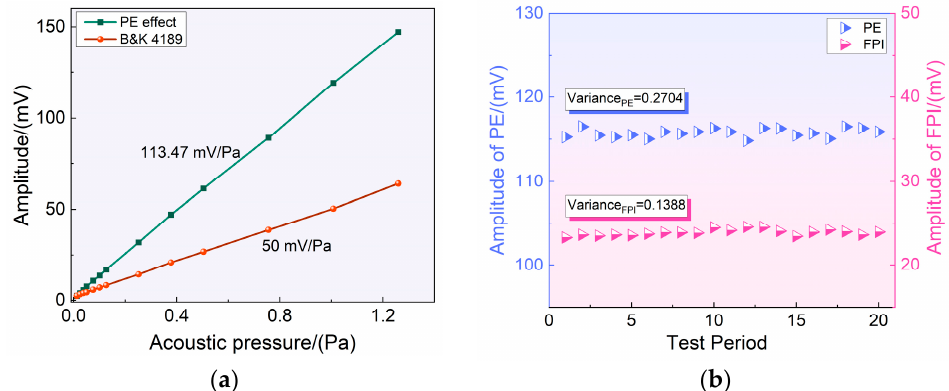
Figure 4. ( a ) Relationship between the piezoelectric effect signal and sound pressure level at the formant; ( b ) stability test of the resonance sensor.